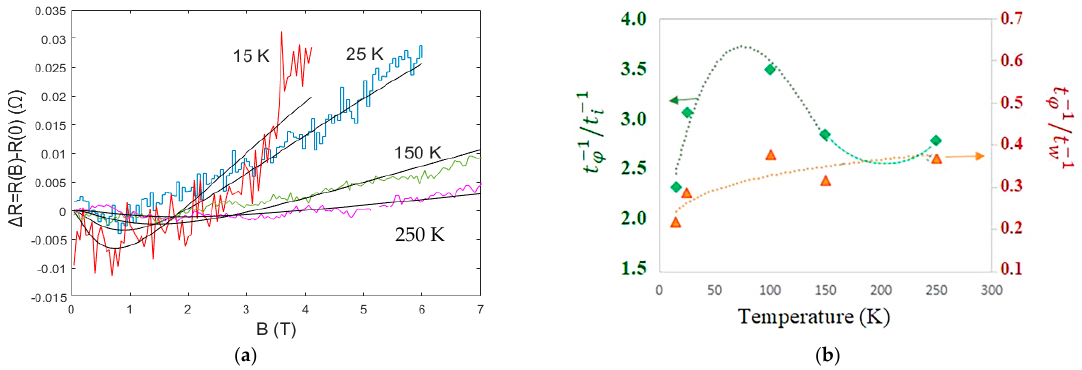
Figure 6. ( a ) The best fit on Sample I by the model of McCann (black line) with the experimental curves of ∆𝑅 = 𝑅(𝐵) − 𝑅(0) as a function of the magnetic field at different temperatures. ( b ) The 𝜏 (cid:3101)(cid:2879)(cid:2869) /𝜏 (cid:3036)(cid:2879)(cid:2869) and 𝜏 (cid:3101)(cid:2879)(cid:2869) /𝜏 (cid:3050)(cid:2879)(cid:2869) rates obtained through the best fit with the 𝜏 (cid:3050)(cid:2879)(cid:2869) fixed.